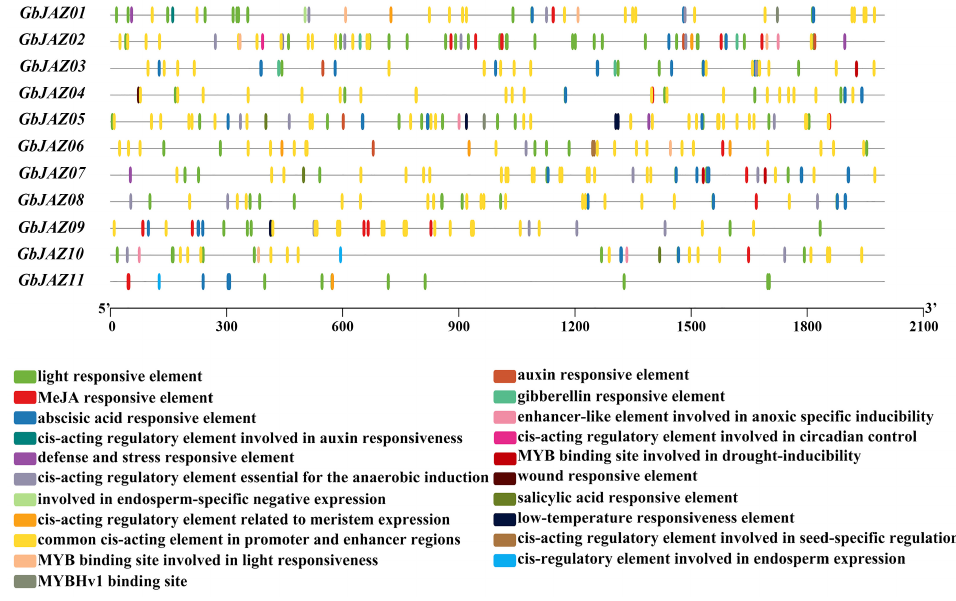
Figure 4. Distribution of cis -acting elements of GbJAZs.